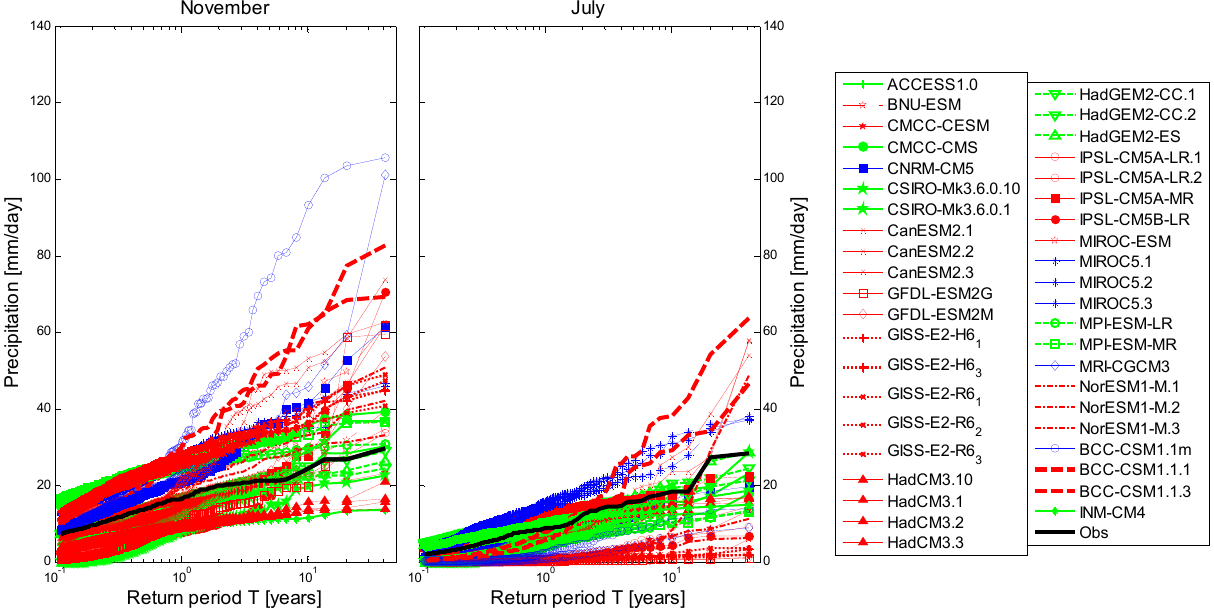
Figure 9. Return period of average daily precipitation for the different GCM simulations for November and July, red: LR GCMs; blue: HR GCMs; green: MR